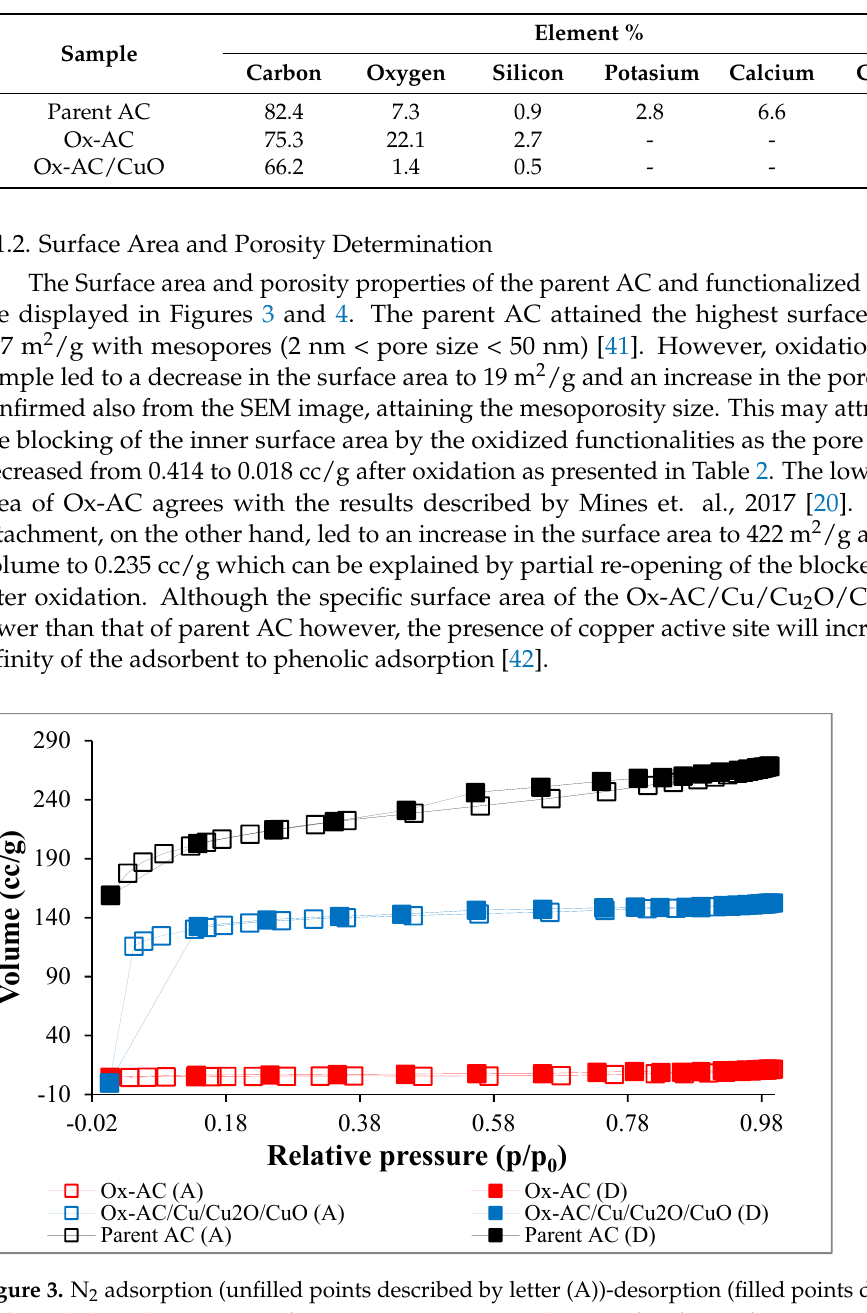
Figure 4. Pores distribution for parent AC, Ox-AC, and Ox-AC/Cu/Cu 2 O/CuO. Table 2. Surface area (BET), total pore volume, and pore size for parent AC, Ox-AC, and Ox-AC/Cu/Cu 2 O/CuO. Sample